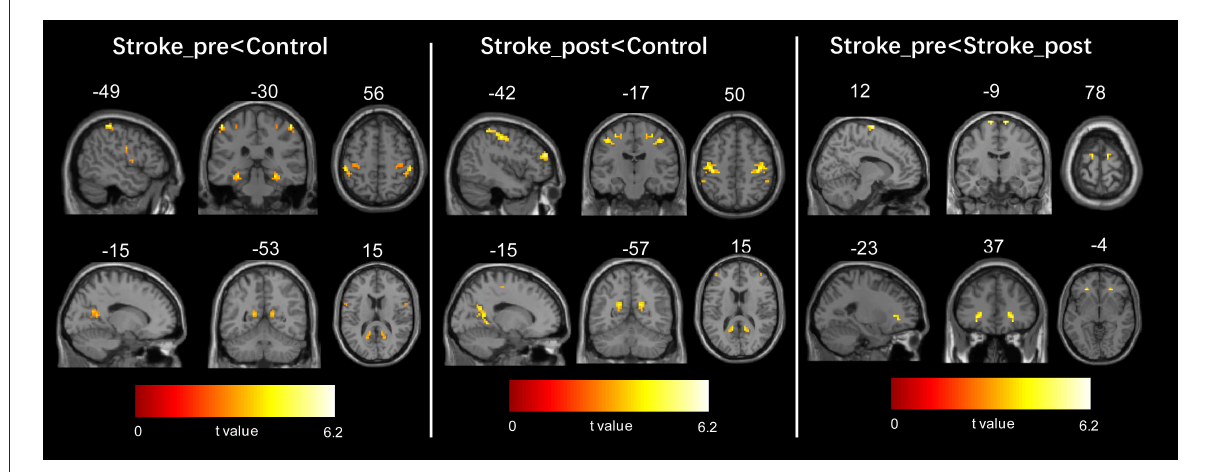
FIGURE2 Regions showing significant changes in voxel-mirrored homotopic connectivity (VMHC) between each pair of the three groups. The threshold of the resulting statistical map was a combination of p < 0.005 for a single voxel and a minimum cluster size of 297 mm 3